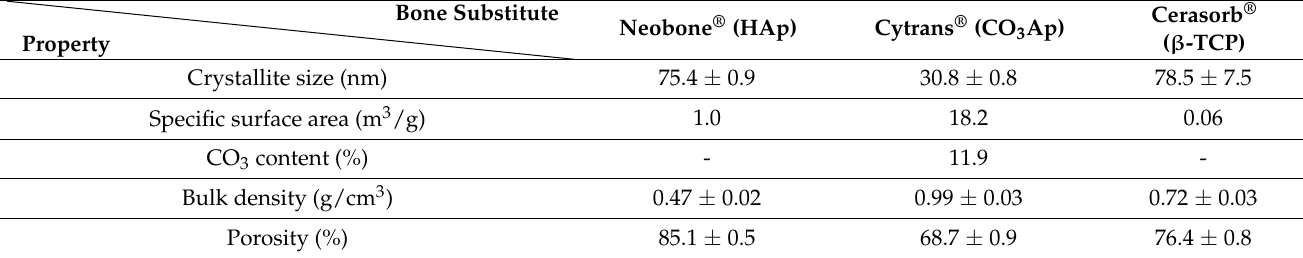
Table 4. Comparison of physical properties of commercially available bone substitutes. Adapted from an open-access source